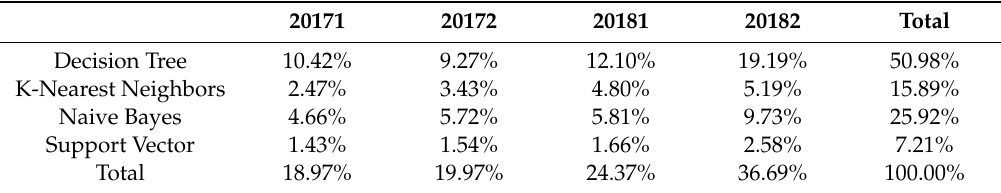
Table 3. Distribution of the classification algorithm selection for 2019 spring